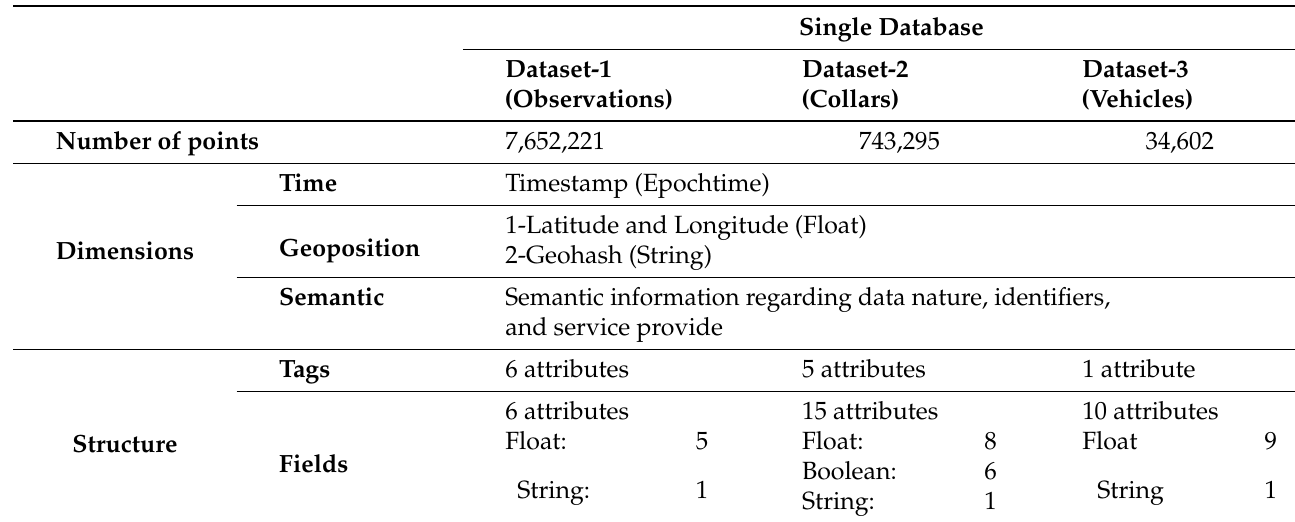
Table 2. Data model for datasets 1, 2, and